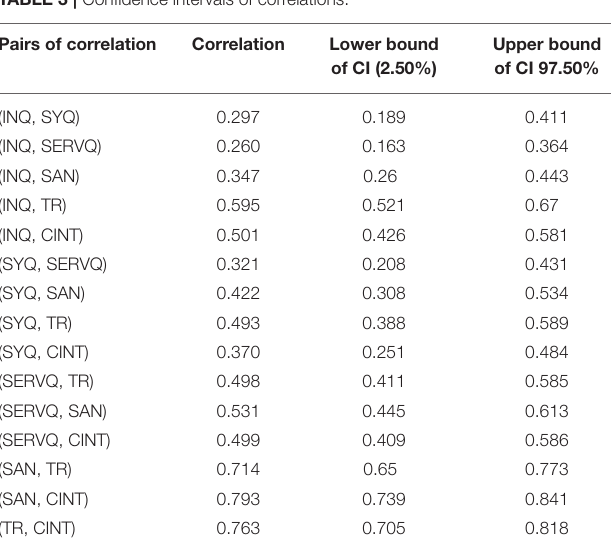
TABLE 3 | Confidence intervals of correlations.